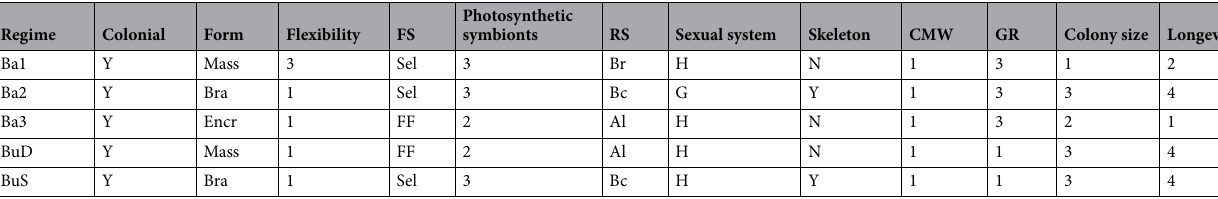
Table 1. Community-weighted-mean values (CWM) for the different traits and benthic communities studied. Body form categories: Mass. massive, Bra. branching, Encr. encrusting. FS categories: Sel. selective, FF filter- feeder. RS categories: Br brooder, Bc. broadcasters, Al. alternate. FS feeding strategy, RS reproductive strategy, CMW corallite maximum width, GR growth